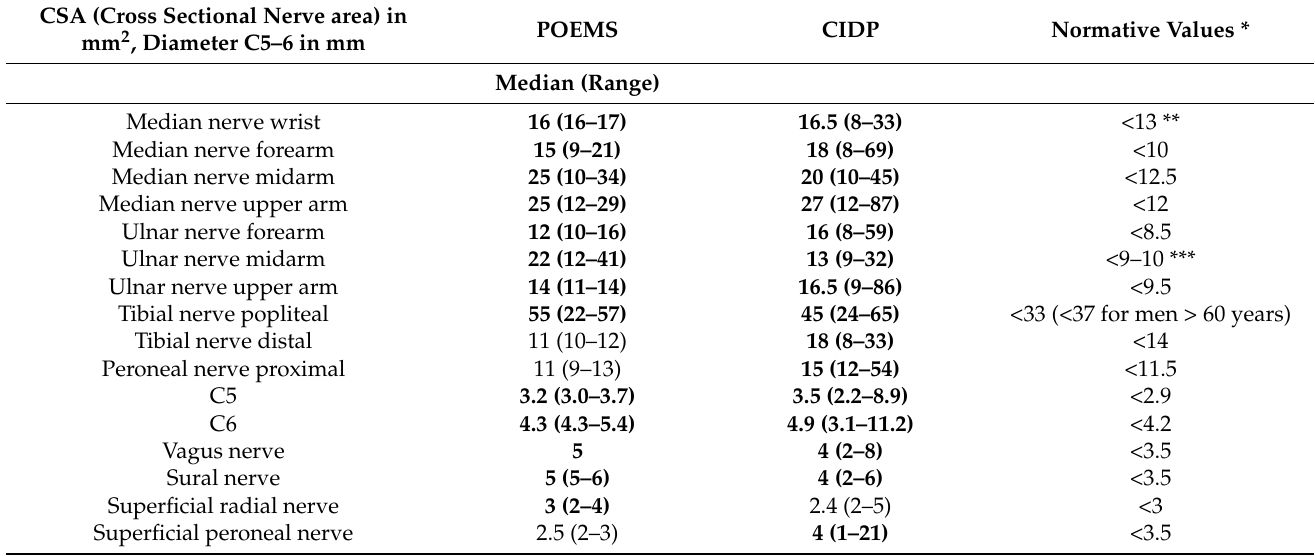
Table 3. HRUS median